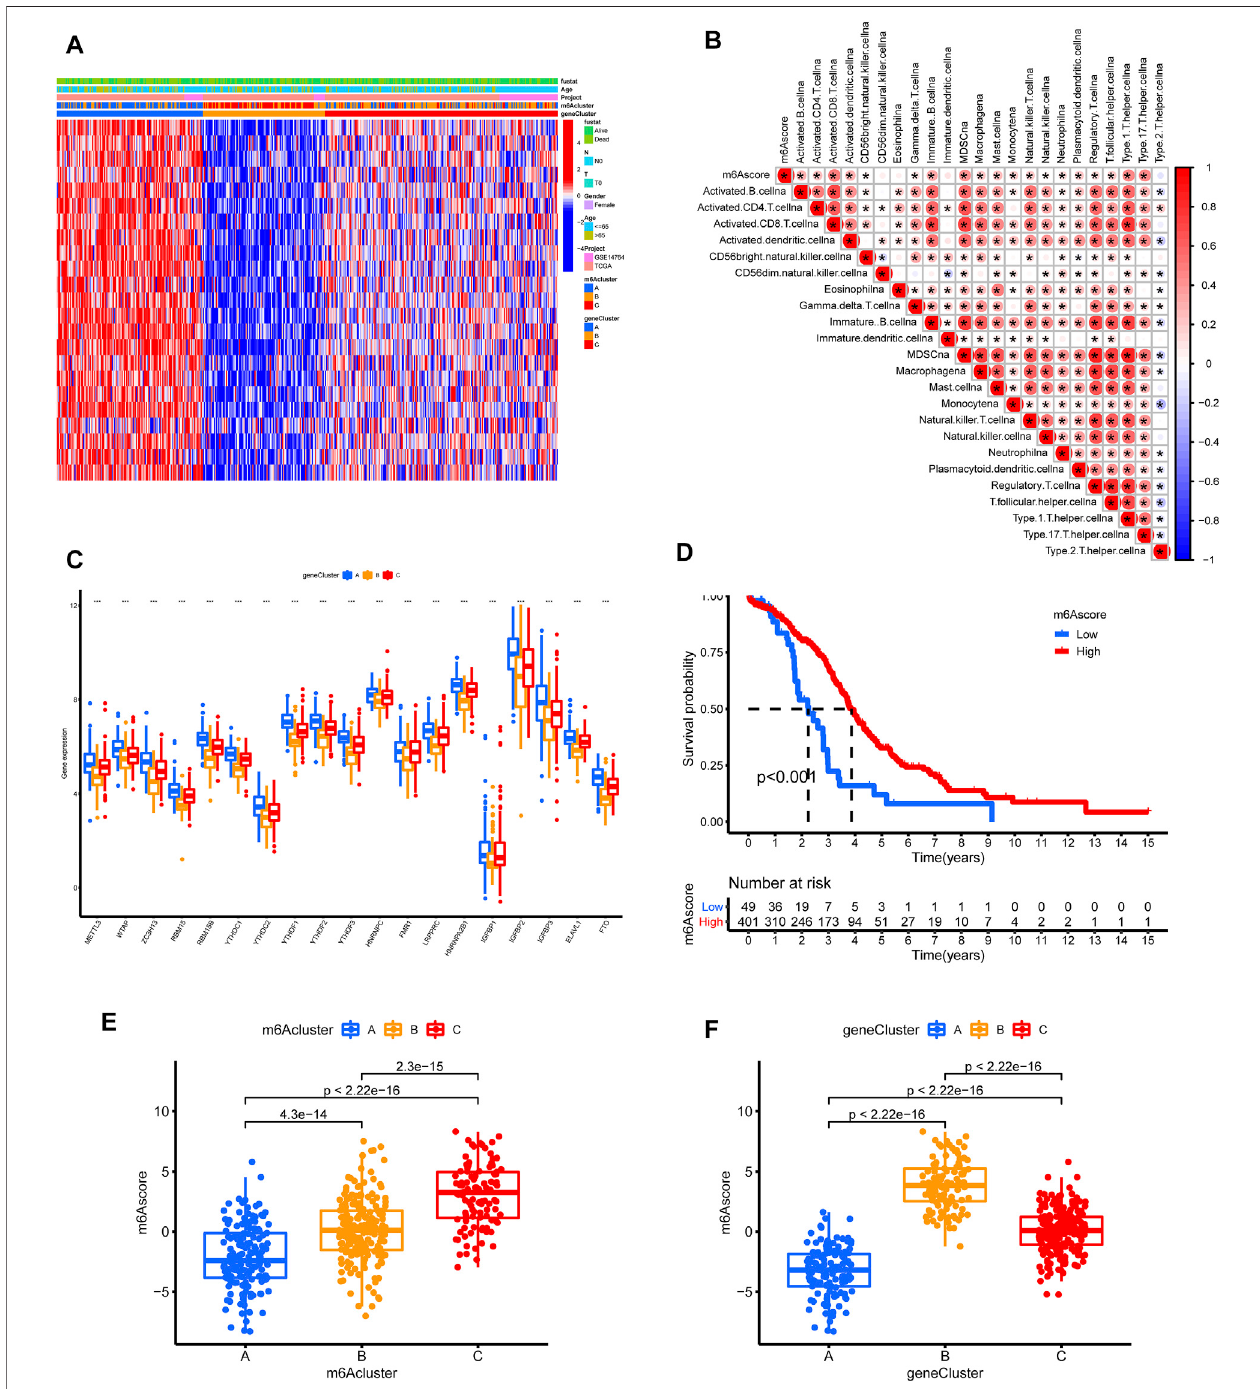
FIGURE6| Constructionofm6AsignatureaccordingtoTCGAandGSE14764cohort. (A) Unsupervisedclusteringofthem6Aphenotype-relatedgenestoclassify patientsintodifferentgenomicsubtypes. (B) Correlationsbetweenm6AscoreandtheTMEin fi ltratingcellusingSpearmananalysis. (C) Theexpressionofm6Aregulators in three gene clusters. (D) Survival analysis for low and high m6Ascore patient groups using Kaplan-Meier curves. (E,F) Comparison of m6Ascores in different m6Aclusters and geneclusters.